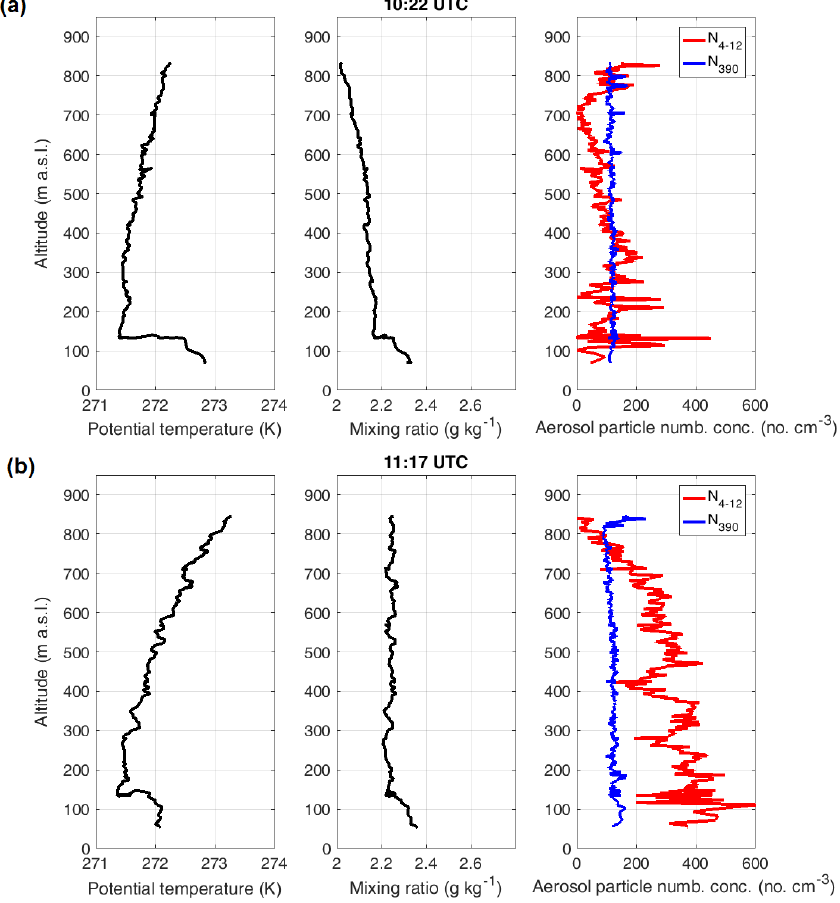
Figure 10. Selected profiles measured on 23 May 2018 in Ny-Ålesund for (a) 10:22 and (b) 11:17UTC. The panels show vertical profiles of the potential temperature, water vapor mixing ratio, and aerosol particle number concentrations between 4 and 12nm and above 390nm.